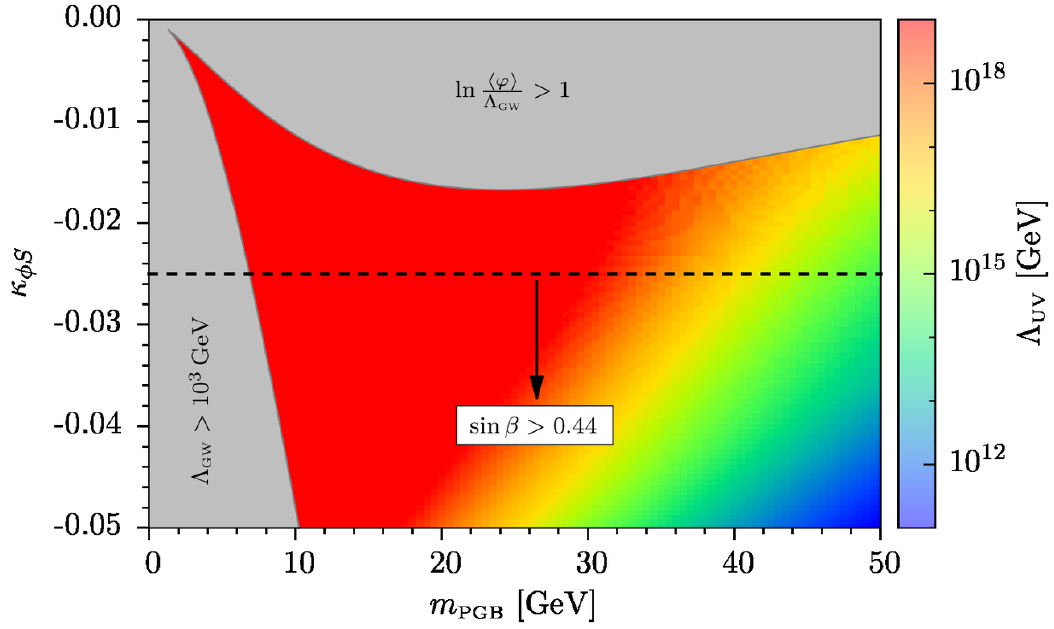
Figure 9 . Largest possible UV scale in the CSMTS. (Case in which the physical Higgs is not the PGB, i.e. (cid:12) >